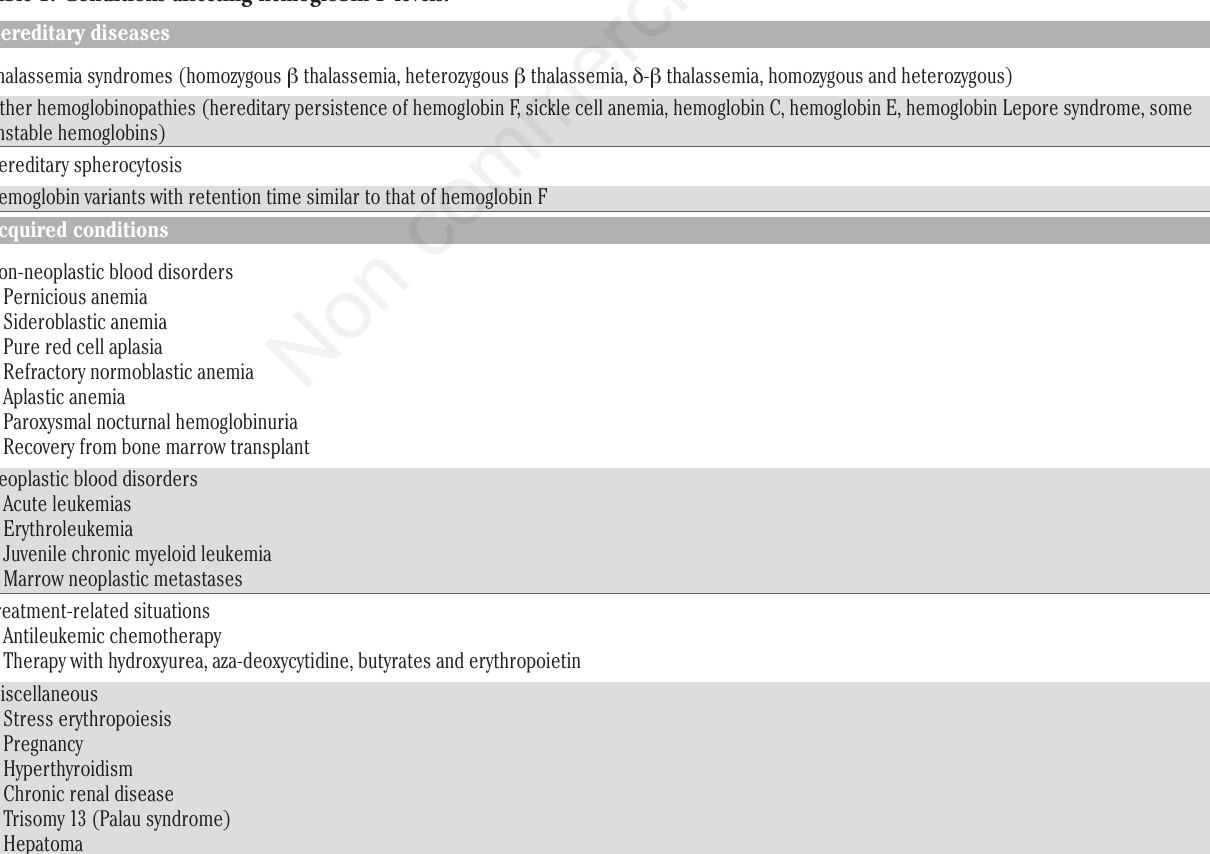
Table 1. Conditions affecting hemoglobin F levels. Hereditary